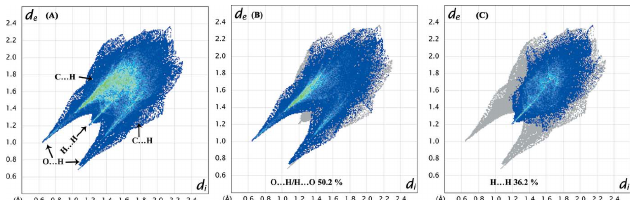
Figure 7 The two-dimensional fingerprint plots for (I): ( A ) a complete unit (various types of contacts are indicated); ( B ) H (cid:3)(cid:3)(cid:3) H contacts and ( C ) O (cid:3)(cid:3)(cid:3) H/H (cid:3)(cid:3)(cid:3) O